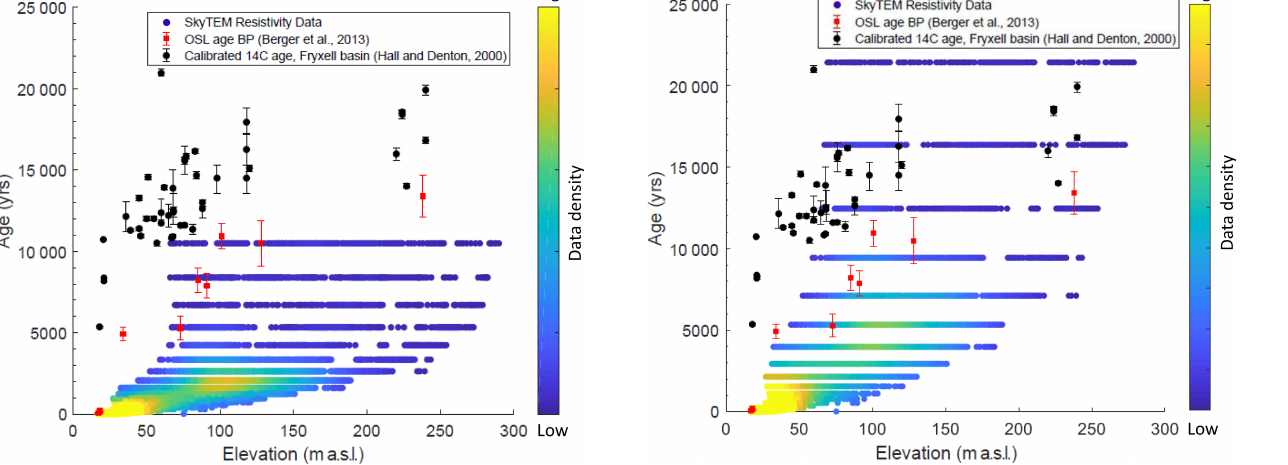
Figure 16. Permafrost ages calculated using the analytical model (Eq. 1) applied to SkyTEM resistivity data. Depth to brine (100 (cid:127) m) and inputs from Table 1 were used in Eq. (1) to calcu- late maximum permafrost age. Permafrost ages are colored by data density, where yellows and greens represent higher data density, and blues represent lower data density. Ages are better constrained for younger, shallower permafrost, so ages were cut off at 400m depth to brine (corresponding to permafrost ages of ∼ 11000 years BP). 14 C (Hall and Denton, 2000) and OSL (Berger et al., 2013) ages collected from deltas in Lake Fryxell basin are plotted for compari- son.